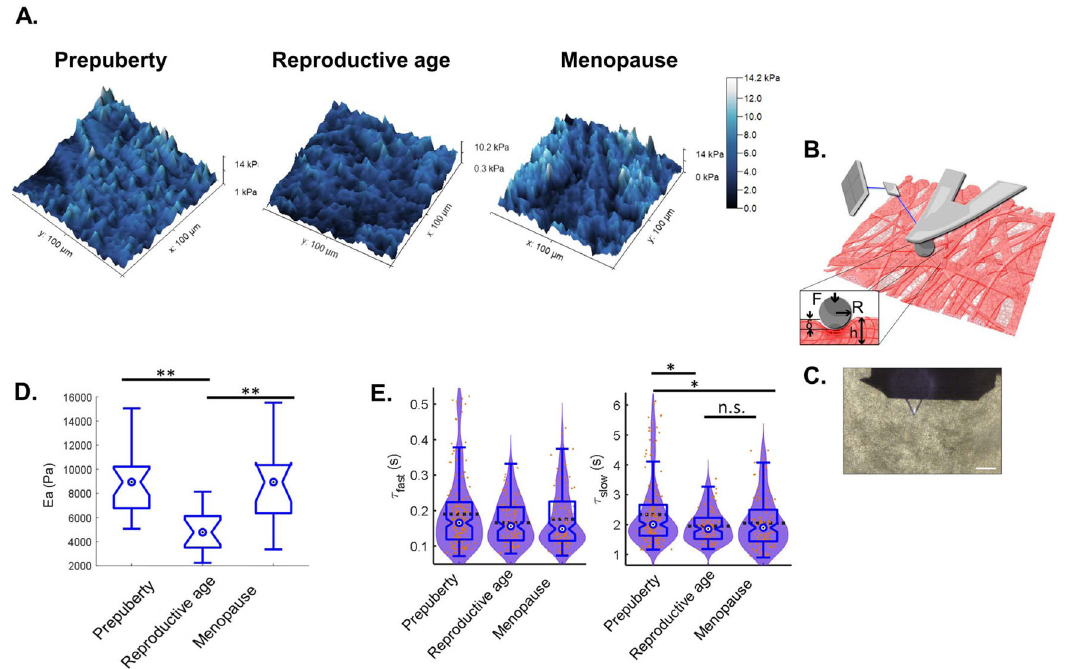
Fig. 5 Elasticity and viscoelasticity of human ovarian tissue. A 3D rendering of AFM maps such as surface height and color re fl ects Young ’ s modulus amplitude measured using a Hertzian model. B Graphic representation of a Hertzian model and AFM measurement of ovarian tissue deformation under AFM spherical probe indentation: R is the probe radius (2.5 µ m), F is the applied force, δ is the indentation, and h is tissue thickness (50 µ m). Deformation induces cantilever de fl ection. An optical system using a laser to detect the tip ’ s de fl ection helped to measure Young ’ s modulus using the Hertzian model. C Transmission microscopic image of the AFM cantilever positioned on top of ovarian tissue in PBS. Scale: 100 µ m. D Elasticity measurements. N = 5 biologically independent samples per age group with at least three analyzed regions per sample. P prepuberty – reproductive age = 3.471e − 5; P menopause – reproductive = 7.619e − 4. E Viscoelasticity measurements. Although ovarian tissue shows signi fi cant elasticity change upon menopause, no signi fi cant difference age was recorded in terms of viscoelasticity ( λ : relaxation time) between reproductive-age and menopausal tissues. A minimum of six measurements on at least nine different points in a sample were recorded for viscoelasticity, which was measured on the same region that was used for force maps. The graphic shows the overlay of violin plots with boxplots. Statistical signi fi cance was obtained using Kruskal – Wallis test followed by Dunn ’ s multiple comparison correction. Boxplots display 25th and 75th percentile, median (blue circle), and the whiskers extending to the last data point not considered outlier. ns: non- signi fi cant; * p < 0.001; ** p <